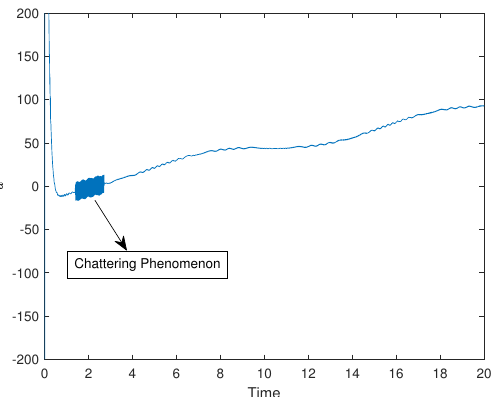
Figure 8. The chattering phenomenon is arisen in the control u without the boundary